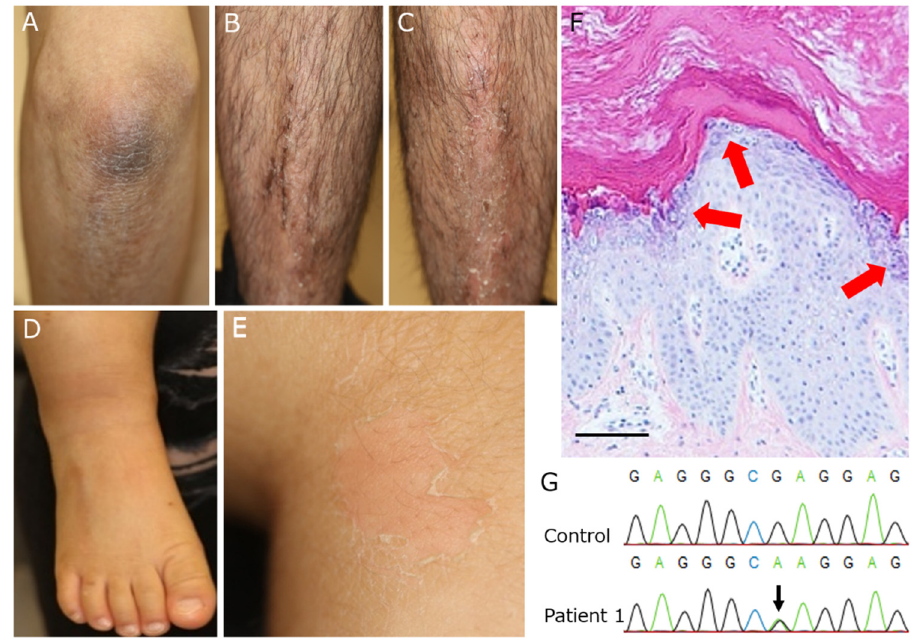
Figure 1. Clinical and histopathological features of the present patients and the causative KRT2 mutation. ( A – C ) In Patient 1, brown, hyperkeratotic lesions with scaling are observed on the elbow (A) and the lower legs ( B , C ). ( D ) In Patient 2, light gray, hyperkeratotic lesions are seen on the extensor side of the ankle joint and the dorsa of the right foot. ( E ) A superficial denuded area, called “Mauserung phenomenon”, is also observed on the flexor side of the knee of Patient 2. ( F ) Histopathological observations of the hyperkeratotic skin on the anterior lower leg of Patient 1 reveal significant hyperkeratosis and granular degeneration restricted to the upper spinous and granular layers of the epidermis (scale bar: 50 μ m). ( G ) Sanger sequencing confirms the heterozygous mutation within KRT2 , c.1459G>A (p.Glu487Lys), in Patient 1.